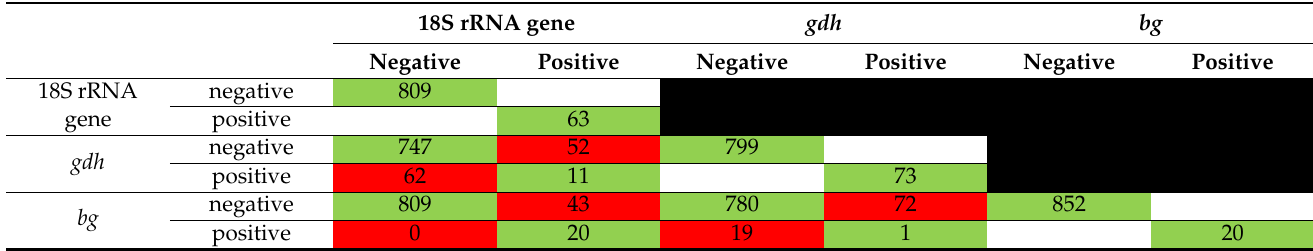
Table A4. Cross-table detailing mismatches between the real-time screening PCR assays target- ing G. duodenalis . Green = matching results. Red = mismatching results. Black = not filled in to avoid